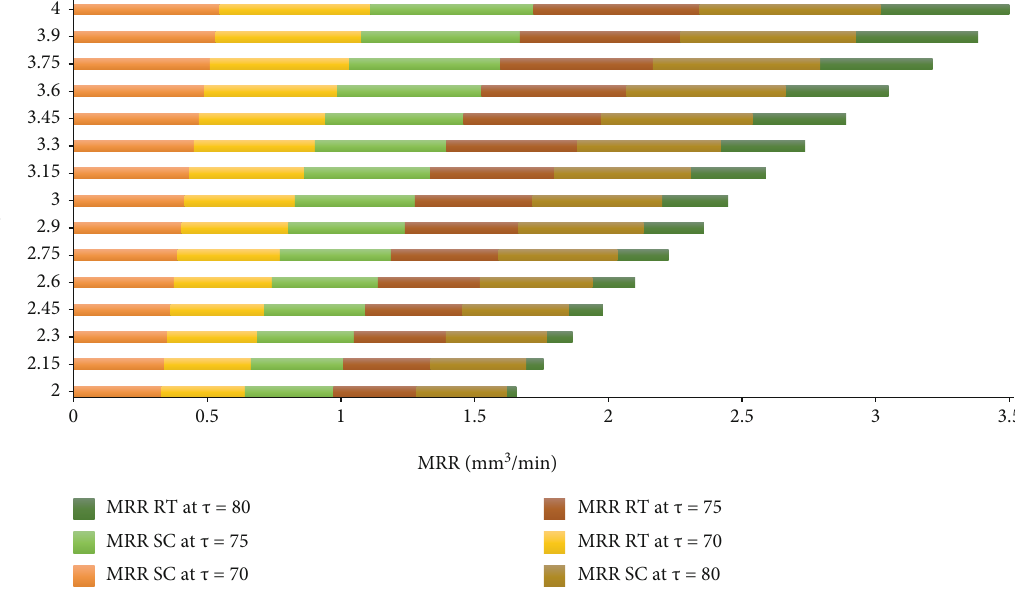
= 50microseconds on